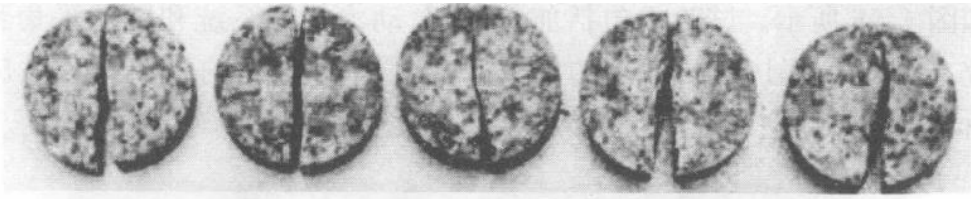
Figure 6. Failure results of specimens in Brazilian splitting physical experiment.